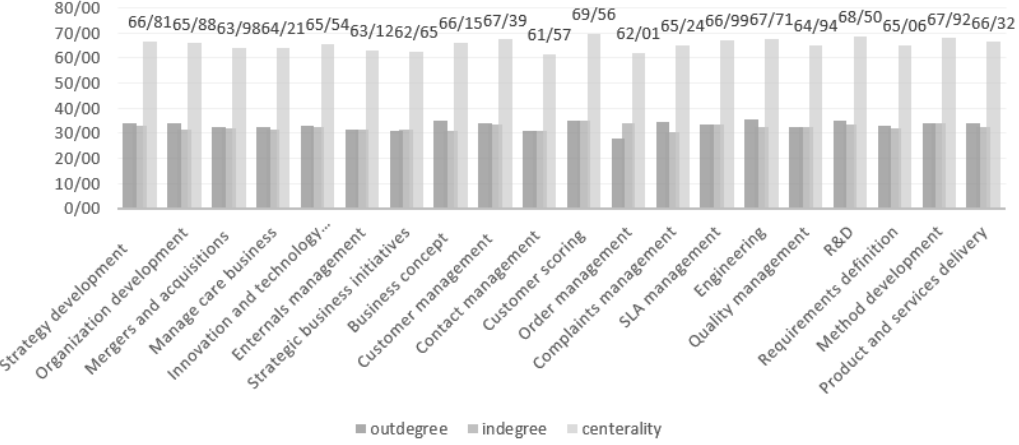
Fig. 4. Network indices: out-degree (O), in-degree (I) and centrality (Ct) = O +